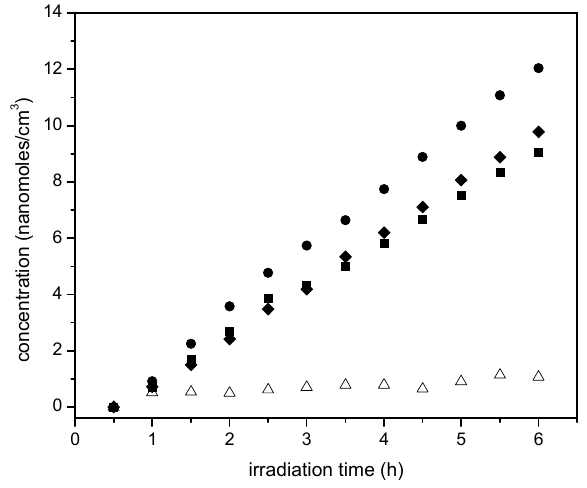
Figure 14. Ethane increase with irradiation time for: ( ● ) 2.50 wt. % Pt–TiO 2 (sol-gel B), ( ■ ) 1.70 wt. % Pt–TiO 2 (sol-gel A), ( ♦ ) 1.70 wt. % Pt–TiO 2 (wetness impregnation) and ( ∆ ) Degussa P25. Standard deviation for repeats is within ± 5%. Table 4. Proposed oxidation reactions over TiO 2 sites.